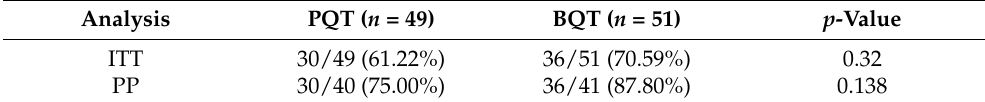
Table 2. Efficacy of H. pylori eradication in the two